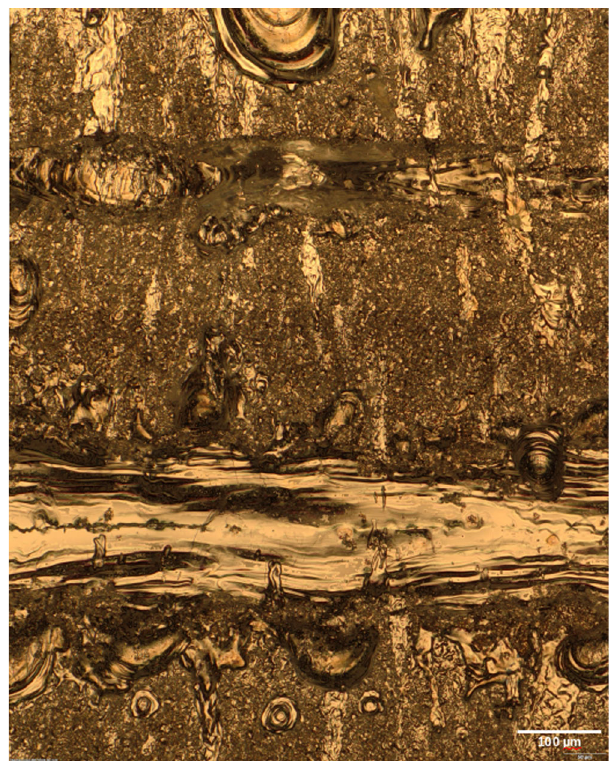
FIG. 25. Adjacent, vertically merged microscopy images of beam strikes SN 06 and 08 (100 mA, upper, and 202 mA, lower), from a 700 - μ m section of the top collimator at location z 0 . The flattened images are recorded at a magnification of